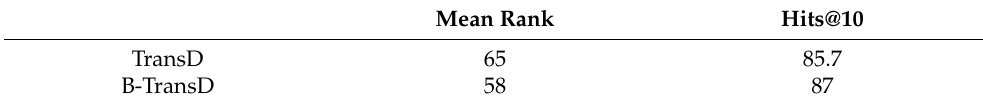
Table 5. Training results.